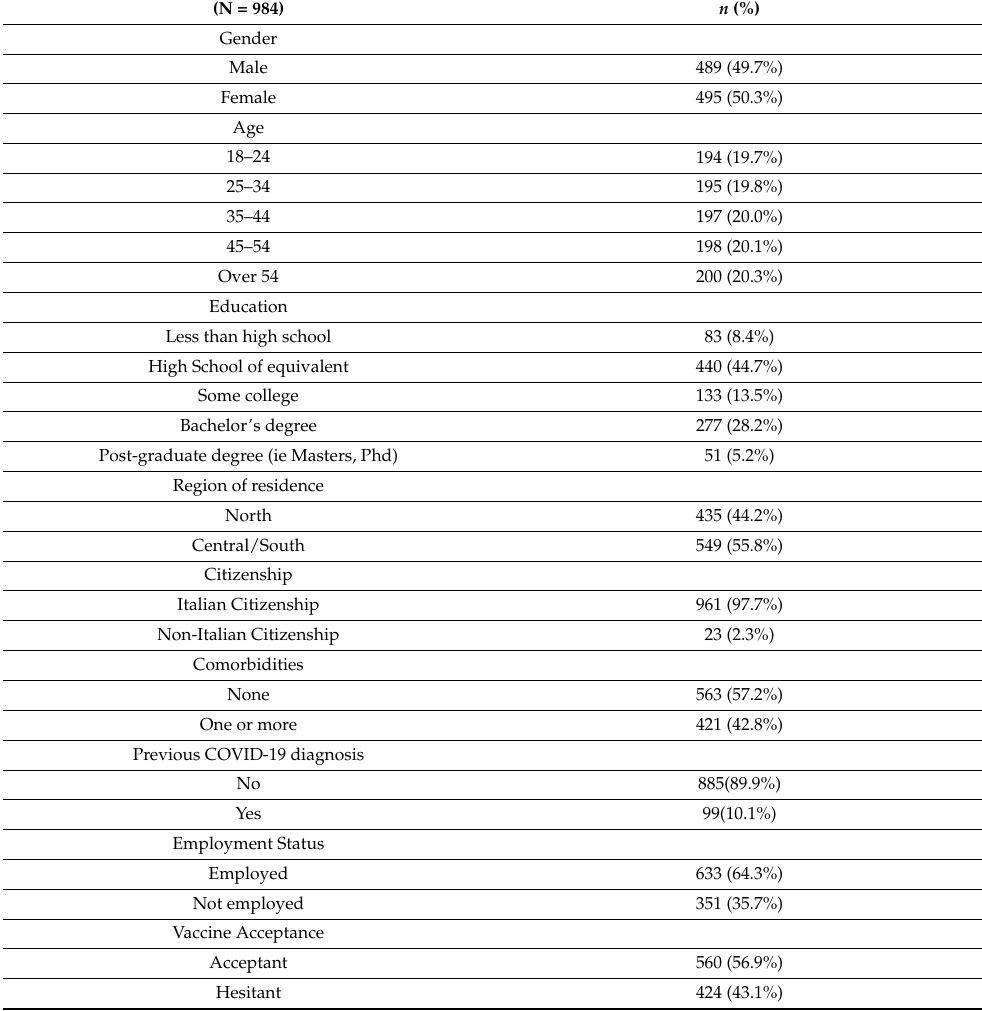
Table 1. Demographic characteristics of study